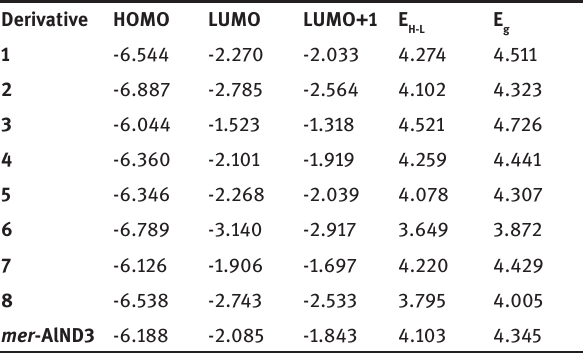
Table 2: Calculated HOMO, LUMO, LUMO+1, and gap energies (E E ) of (1-8) (in eVs) in their ground state (S g